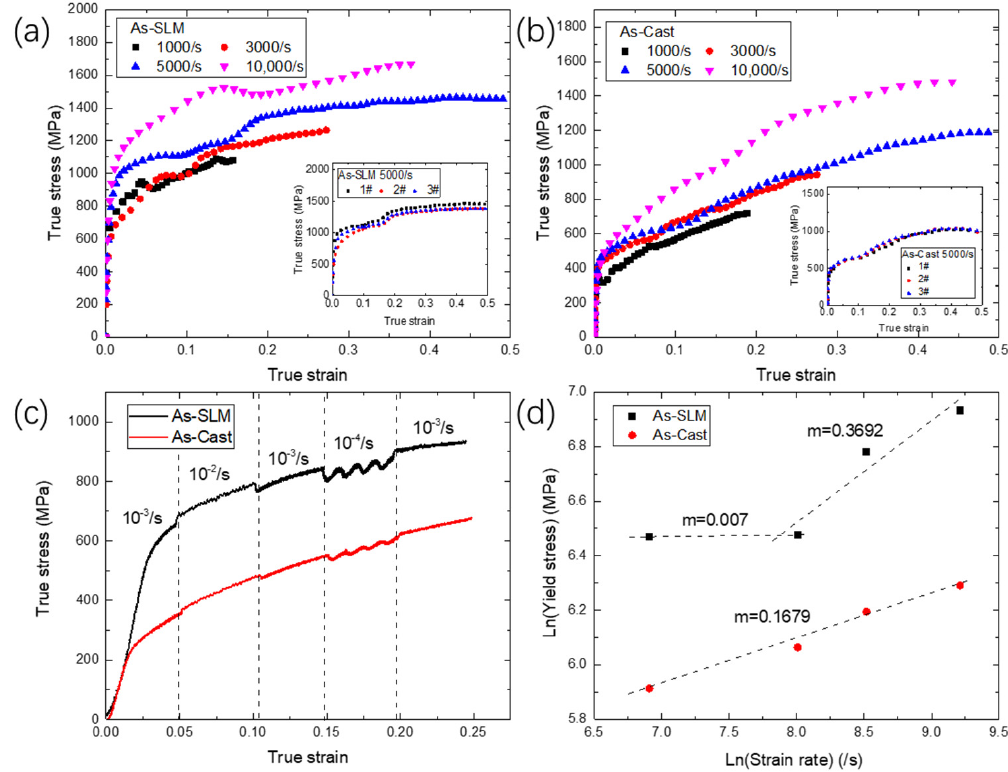
Figure 2. True stress-strain curves under different strain rate. ( a , b ) dynamic compressive true stress-strain curves of the As-cast and As-SLM specimens, respectively, with insets showing the reproductivity of the data. ( c ) strain rate jump tests curves. ( d ) dual logarithmic map of yield stress and strain rate.